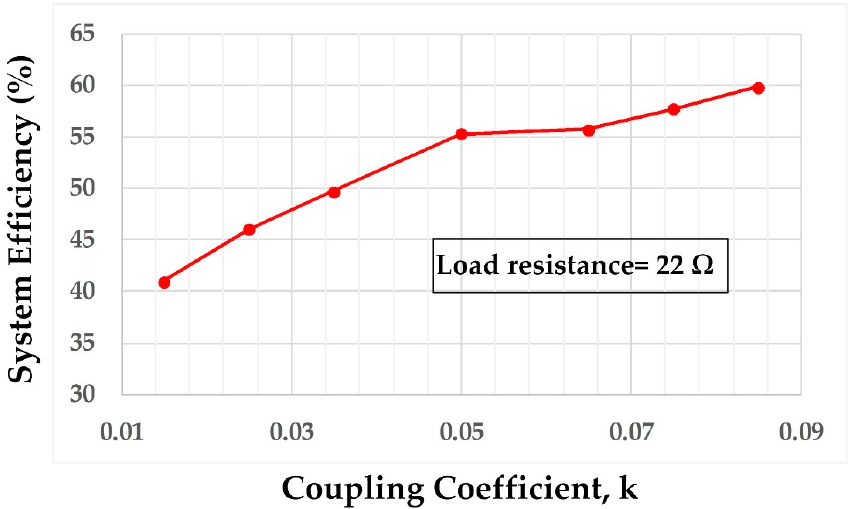
Figure 12. System efficiency against all the four load variations.